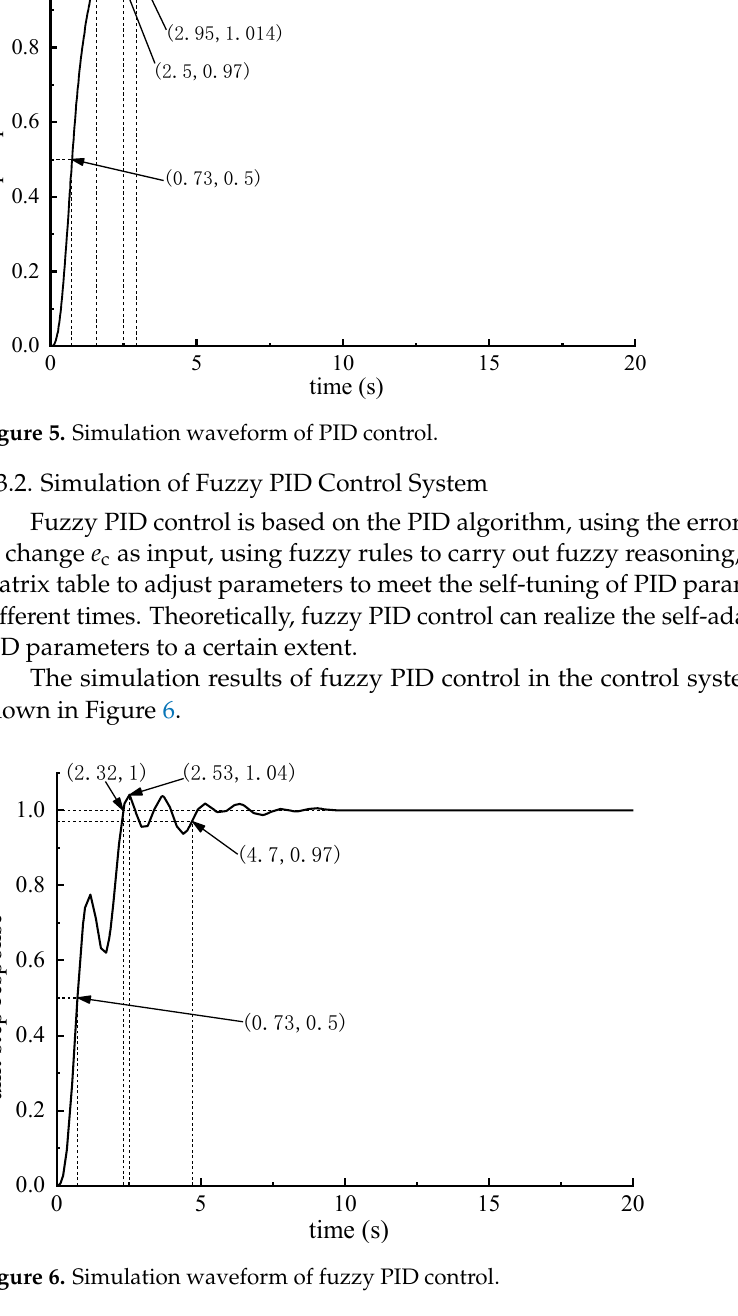
( b ) Figure 7. The optimized simulation results are as: ( a ) Iterative process of optimal individual fitness; ( b ) Simulation waveform of PID control based on beetle antennae search algorithm. According to Figure 7b, the delay time of the transient response of the system is 0.65 s. When the error of the control system is stable within 3%, the response time is 1.2 s, and the overshoot is 0.006. Compared with PID control, the response time of the system after the optimization of the beetle antennae search algorithm is reduced by 1.3 s, and the overshoot is reduced by 0.008. Compared with fuzzy PID, the response time of the system optimized by the